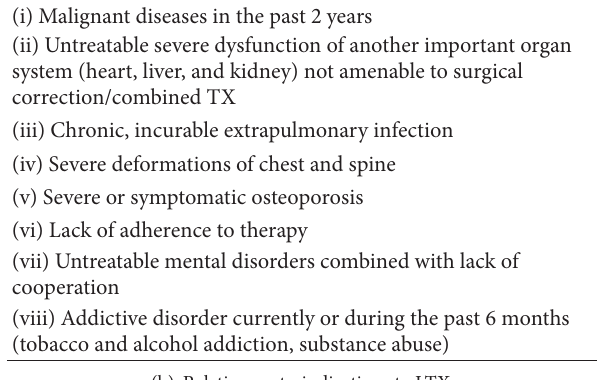
Table 2: Contraindications to